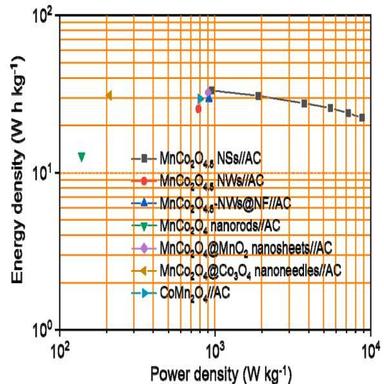
Ragone plots of MnCo2O4.5 NSs//AC HSC and some other HSCs assembled with MnCo-based oxides in the previous reports.